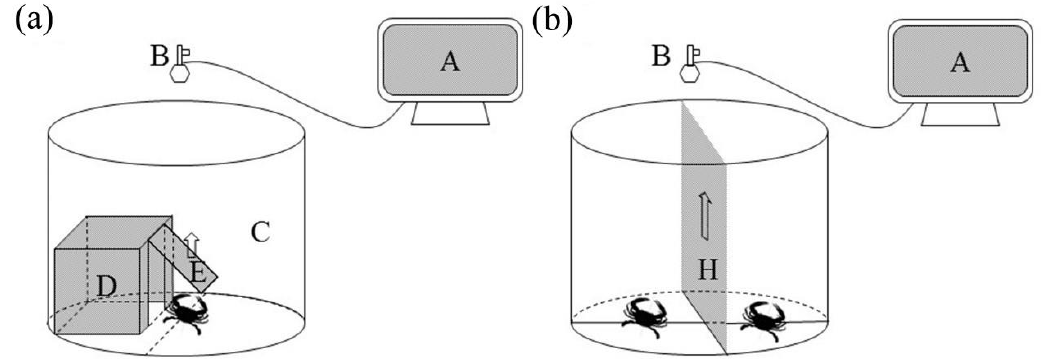
Figure 1. Personality recording system ( a ) and agonistic behavior recording system ( b ). Note: (A) monitor; (B) infrared camera; (C) cylindrical experimental aquarium; (D) box shelter (30 × 20 × 20 cm); (E) trapdoor (20 × 20 cm); and (H) separator board (60 × 50 cm). In the experiment, only healthy (all appendages intact, normal ingestion) female (car- apace width: 90.6 ± 5.4 mm, n = 48) and male (carapace width: = 89.1 ± 3.9 mm, n = 48) individuals in intermolt stage with intact appendages were used only once. To measure